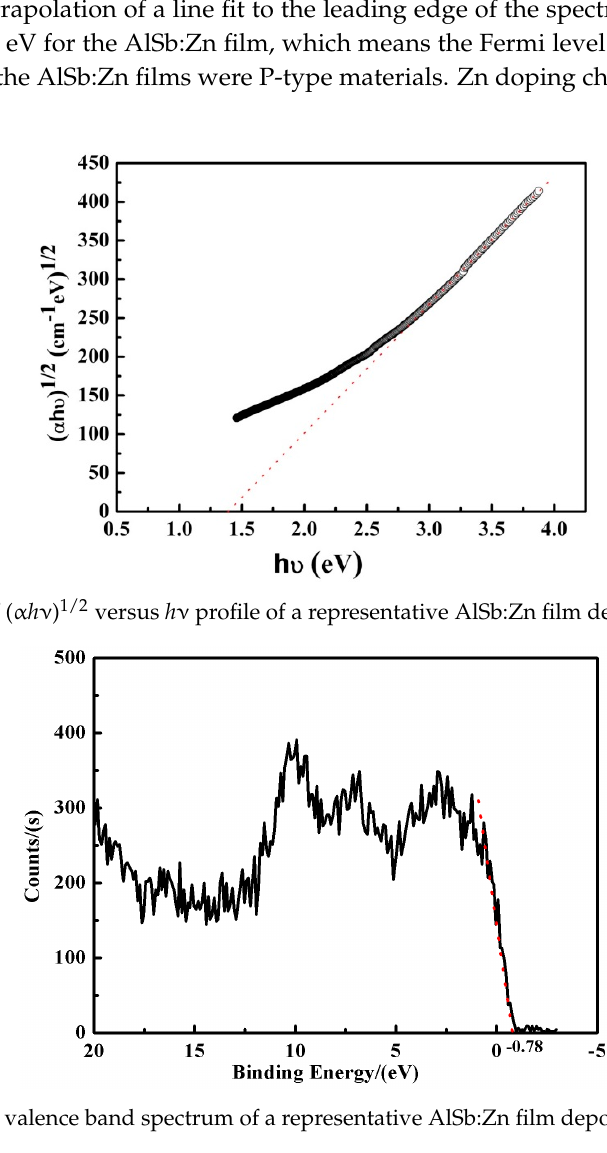
Figure 7. The valence band spectrum of a representative AlSb:Zn film deposited at 400 °C.